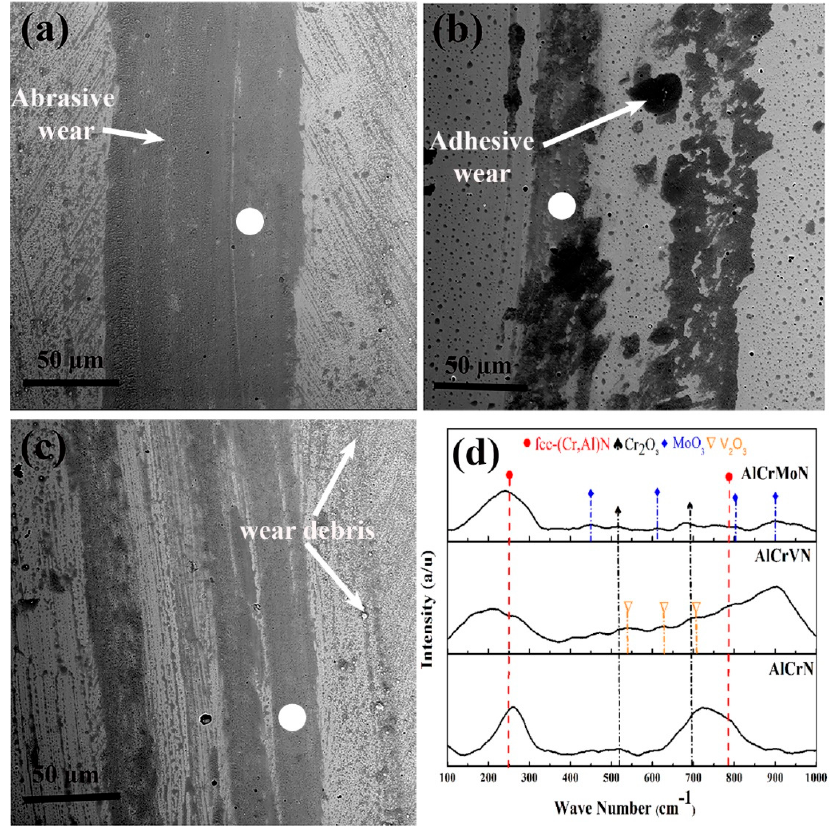
Figure 5. Typical scanning electron microscopy (SEM) micrographs of worn track morphologies on coated CC substrates ( a ) AlCrN coating, ( b ) AlCrVN coating, ( c ) AlCrMoN coating, and ( d ) Raman